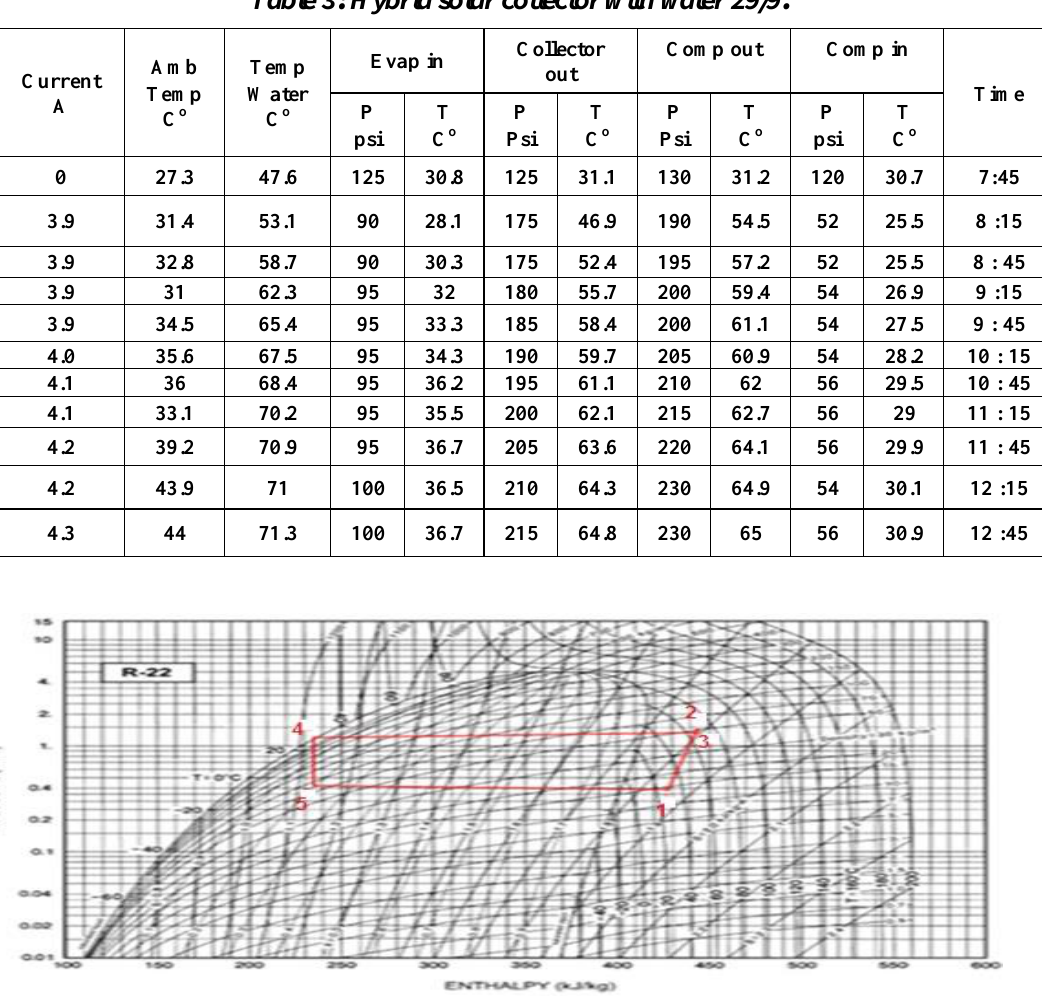
Fig.10: P-h chart with water 28/9. Table 3: Hybrid solar collector with water 29/9.